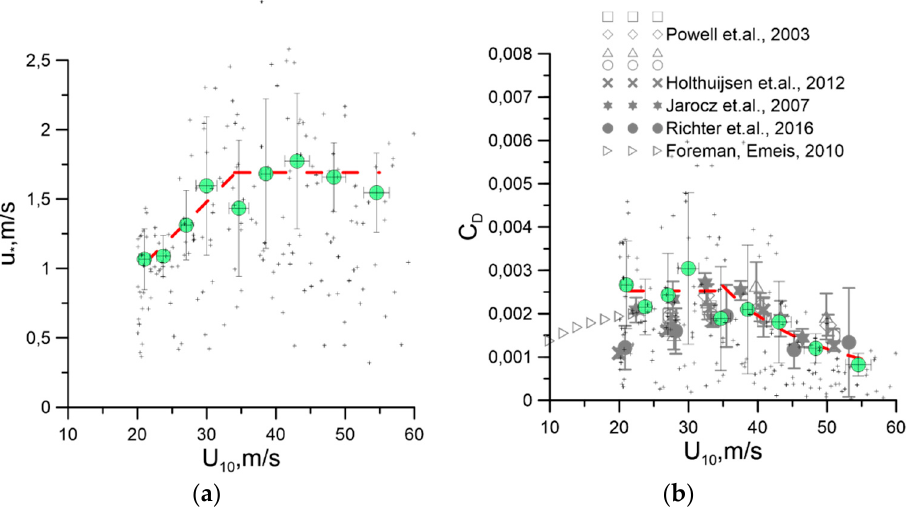
Figure 5. Dependence of the wind friction velocity u ∗ on U 10 ( a ) and the aerodynamic drag coefficient of the ocean surface on U 10 ( b ). Black symbols are the results of calculations for individual statistical ensembles, green symbols are averaged values, red lines are power-law approximations. The grey symbols are field measurements from [12,15,16,18,31].